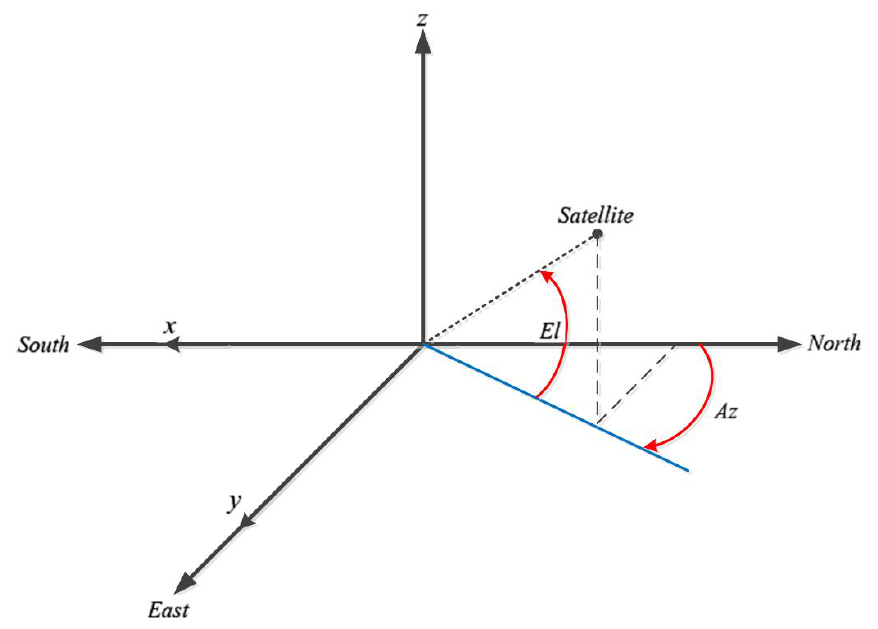
Figure 1. Satellite El/Az angles in earth station.